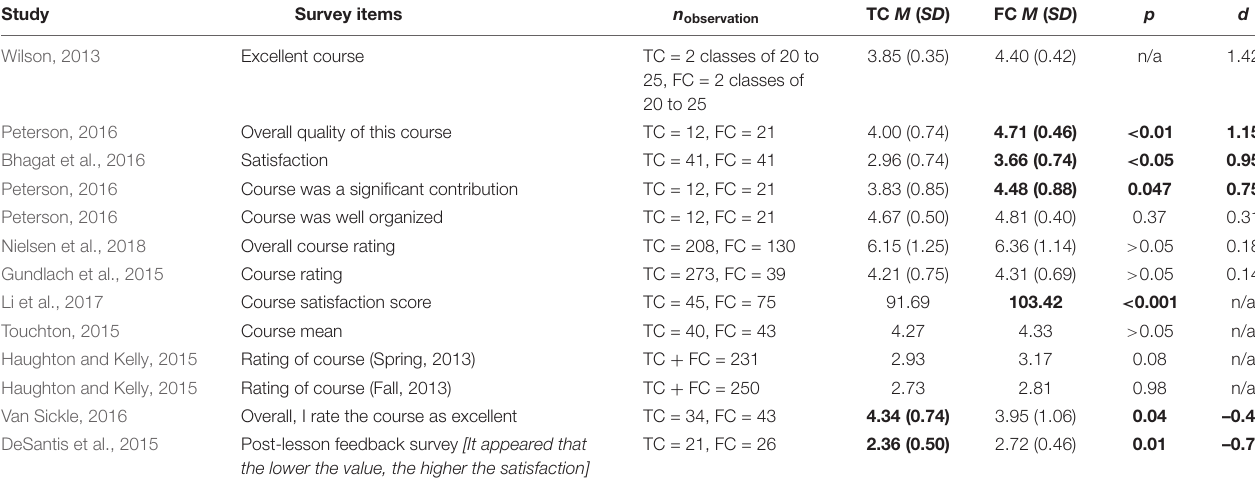
TABLE 4 | Survey results: Course satisfaction by effect size.